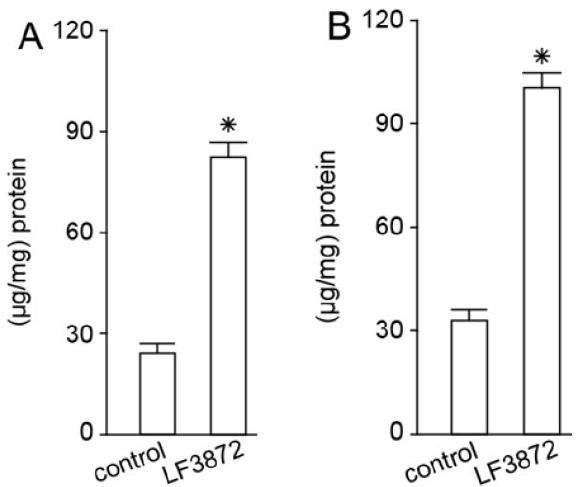
Figure 4. LF3872 stimulates the production of ( A ) TGF- β , ( B ) IgA, and ( C ) IFN- γ in Peyer’s patches of mice. * p < 0.05. Data are presented as the means ± SEM of three independent experiments, tested in triplicate.